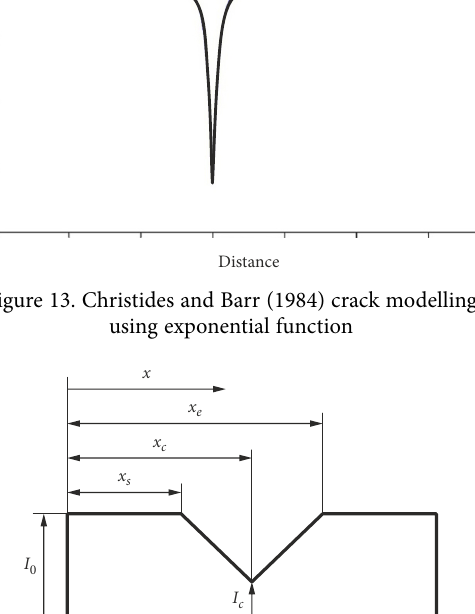
Table 7. Additional parameters for vertical bending